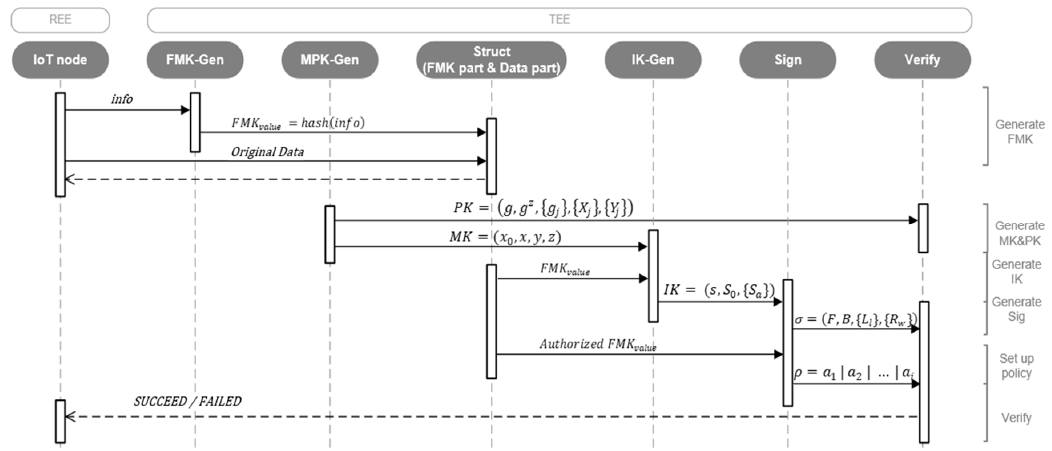
Figure 4. The dominant modules in a secure scheme.